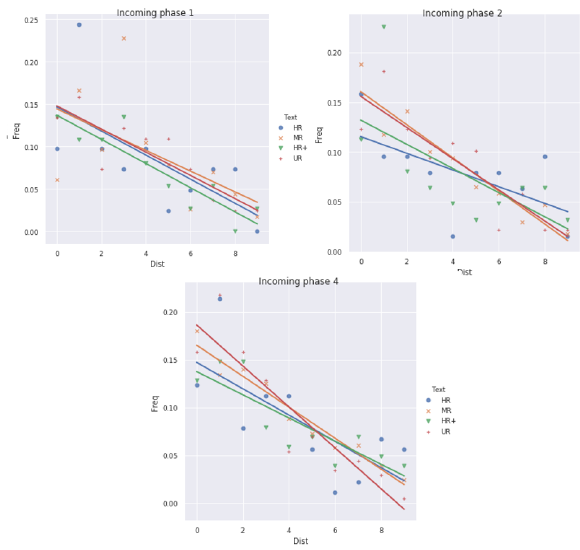
Figure 6. Relationship between distance to trigger words and fre- quencies of transitions arriving into phase 1 (normal reading, top left), 2 (information search, top right) and 4 (slow confirmation,